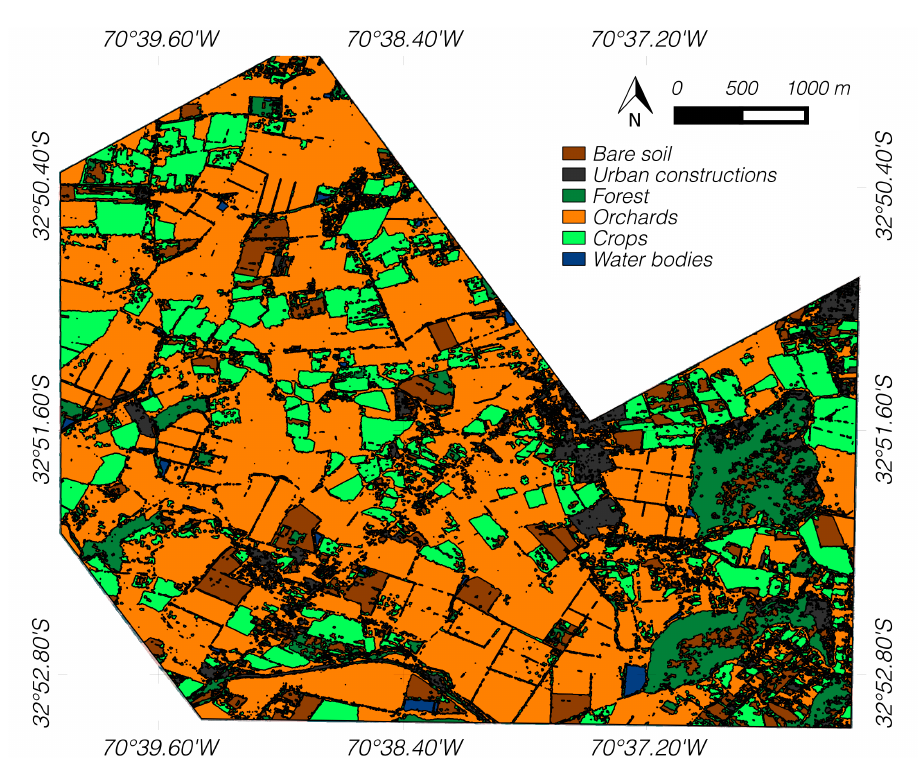
Figure 6. Superpixel map generated through the classification of superpixels according to the interest